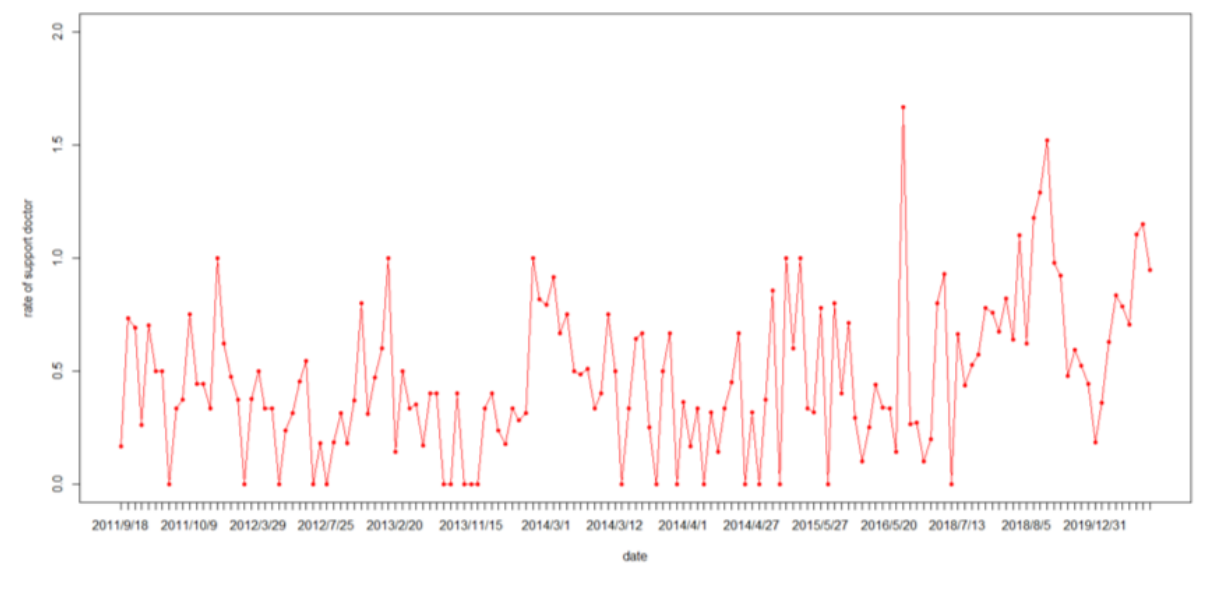
Figure 1. The rate of support doctors at the 151 time points from 2011–2020.